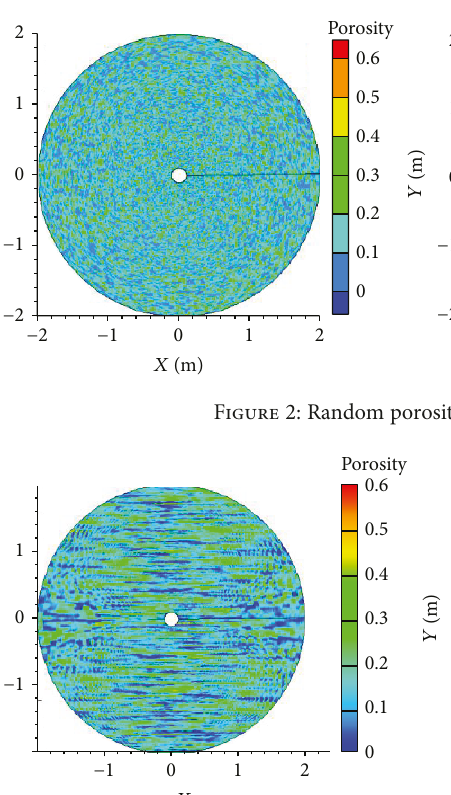
Figure 3: Spatially correlated porosity distribution ( l